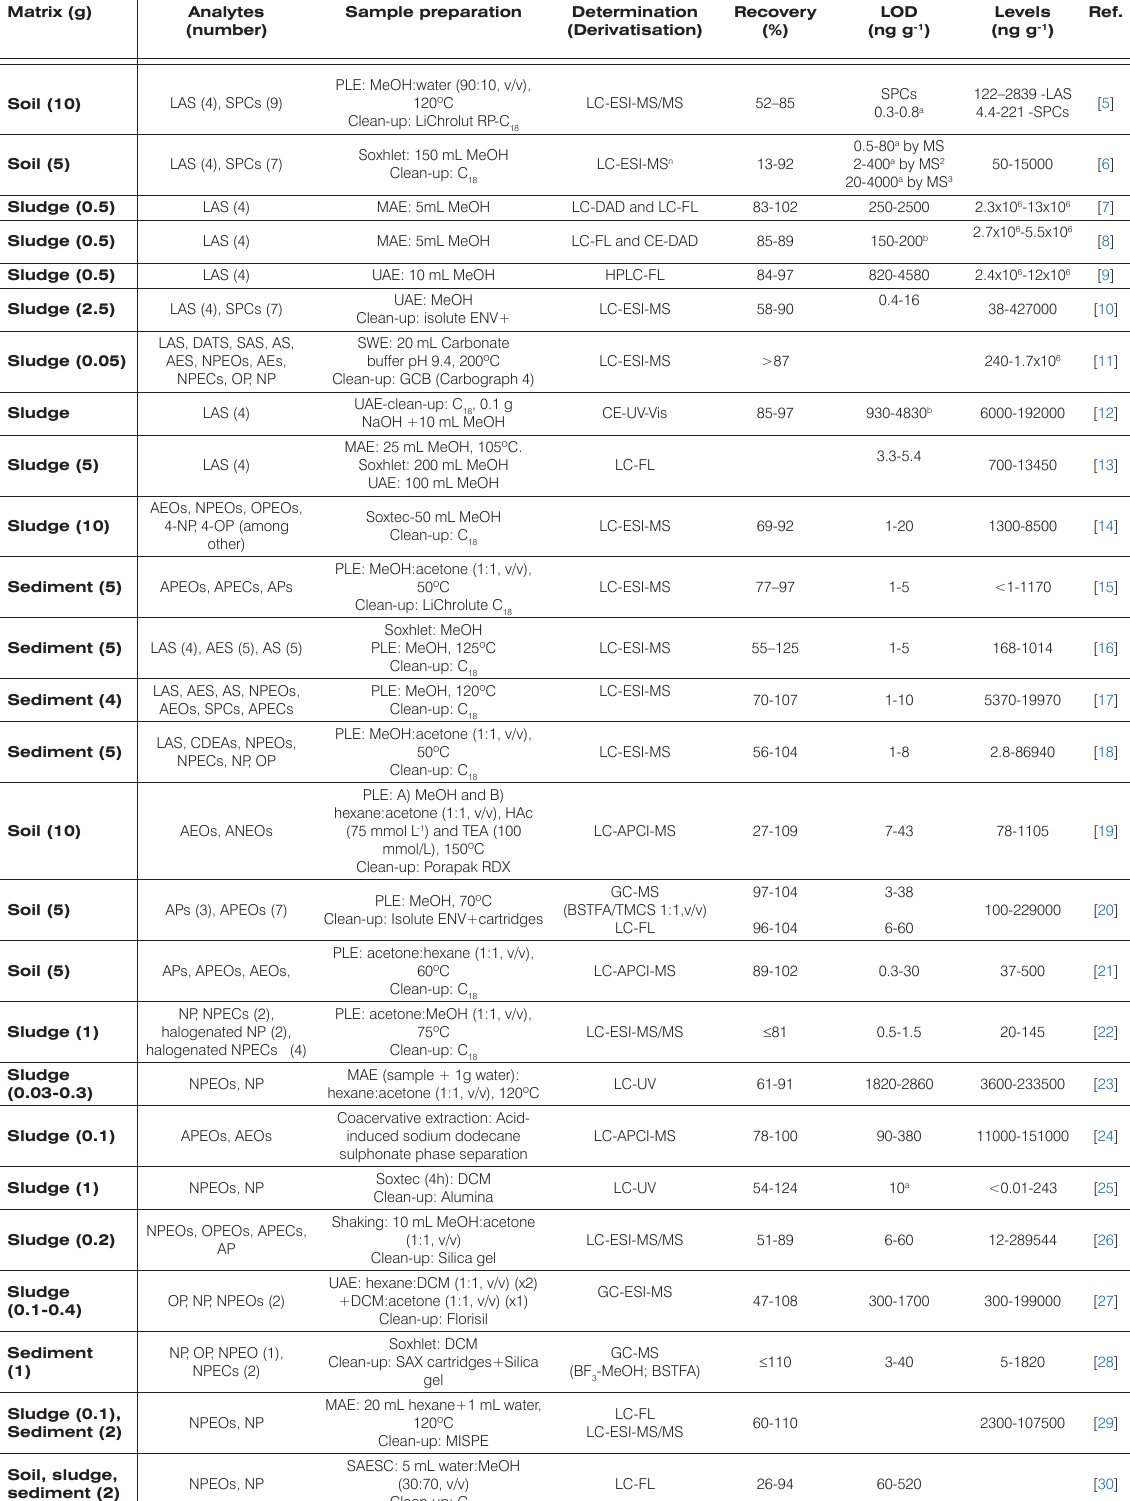
Table 1. Analysis of surfactants in environmental solid